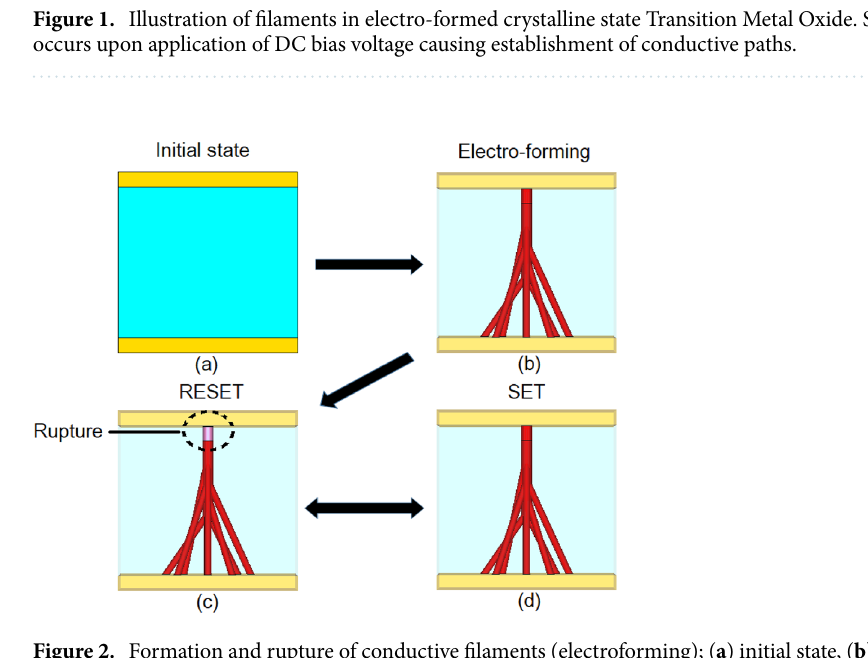
Figure 2. Formation and rupture of conductive filaments (electroforming); ( a ) initial state, ( b ) electro- formation of filament, ( c ) rupture of filament, RESET state and ( d ) reversible SET